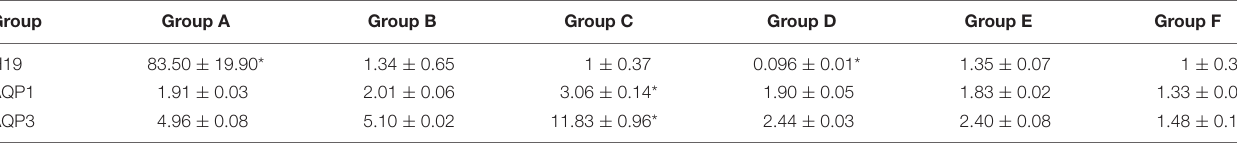
TABLE 3 | In vitro analysis in Caco-2 cells models for H19 transfection and siH19 interference. Group Group A Group B Group C Group D Group E Group F H19 83 . 50 ± 19 . 90 * 1 . 34 ± 0 . 65 1 ± 0 . 37 0 . 096 ± 0 . 01 * 1 . 35 ± 0 . 07 1 ± 0 . 33 AQP1 1 . 91 ± 0 . 03 2 . 01 ± 0 . 06 3 . 06 ± 0 . 14 * 1 . 90 ± 0 . 05 1 . 83 ± 0 . 02 1 . 33 ± 0 . 08 * AQP3 4 . 96 ± 0 . 08 5 . 10 ± 0 . 02 11 . 83 ± 0 . 96 * 2 . 44 ± 0 . 03